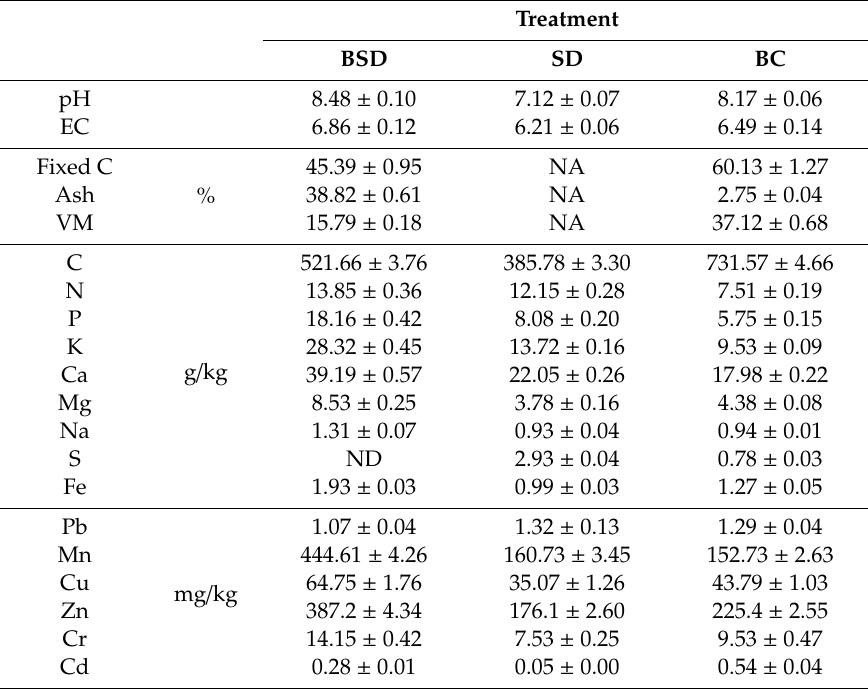
Table 1. Characteristics of soil amendments tested in maize